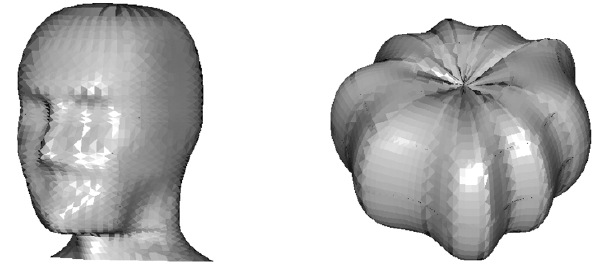
Figure 3: Head and Pumpkin models.